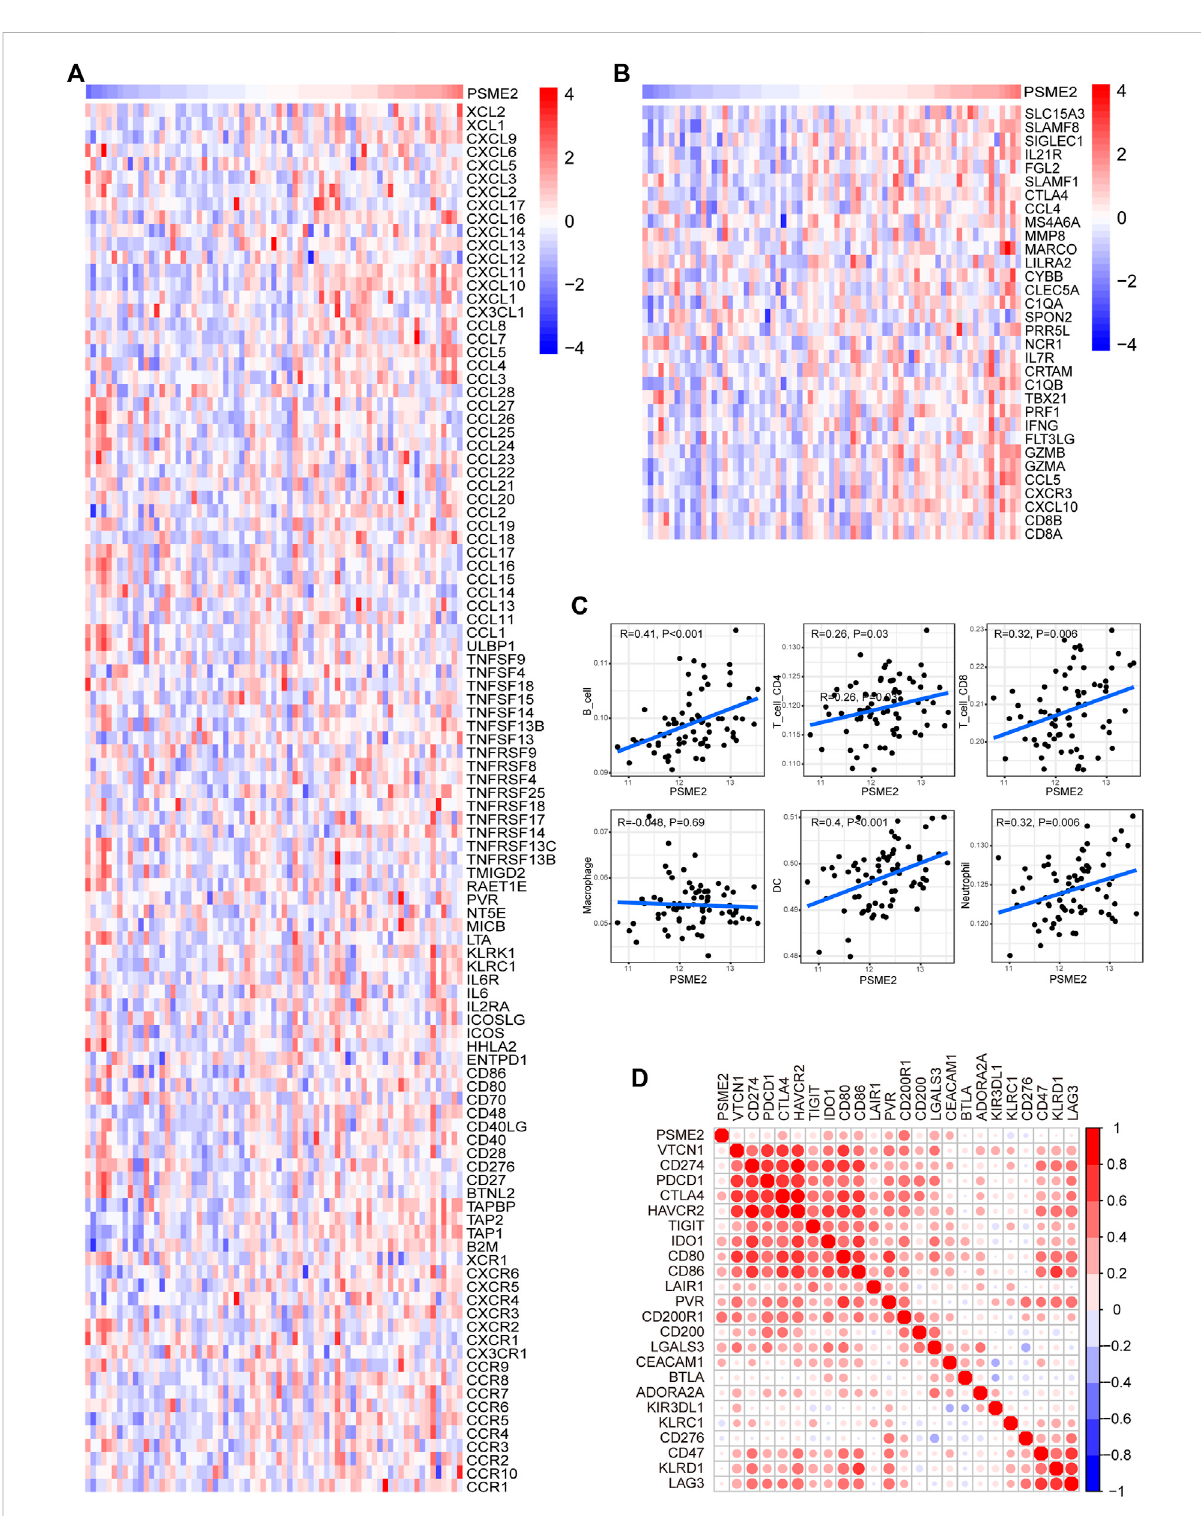
Associations between PSME2 and TIME features in the GSE173839 dataset (A) Expression levels of immunomodulators (chemokines, immunostimulators, MHC, and receptors) in the high- and low-PSME2 groups in BrCa. Red: high expression, blue: low expression (B) Expression levels of the gene markers of the common TIICs in the high- and low-PSME2 groups. Red: high expression, blue: low expression (C) Correlation between PSME2 and levels of TIICs calculated using the TIMER algorithms (D) Correlations between PSME2 and common inhibitory immune checkpoints. The color and the values indicate the Pearson correlation coef fi cient. Data of Figure 6 was obtained from the GSE173839